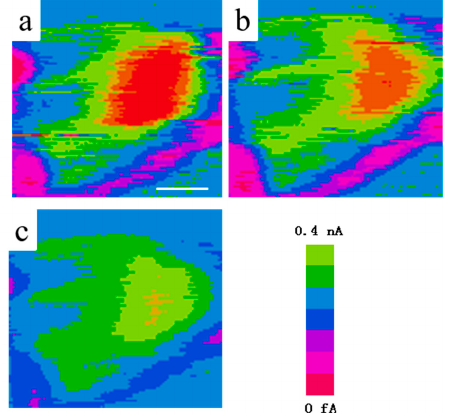
Figure 8. STM images of the graphene-TNTs composite ( a ) without illumination; ( b ) under visible light illumination and ( c ) under UV-light irradiation. The scale bar is 20 nm. Reproduced with permission from [14]. Copyright Elsevier, 2013.